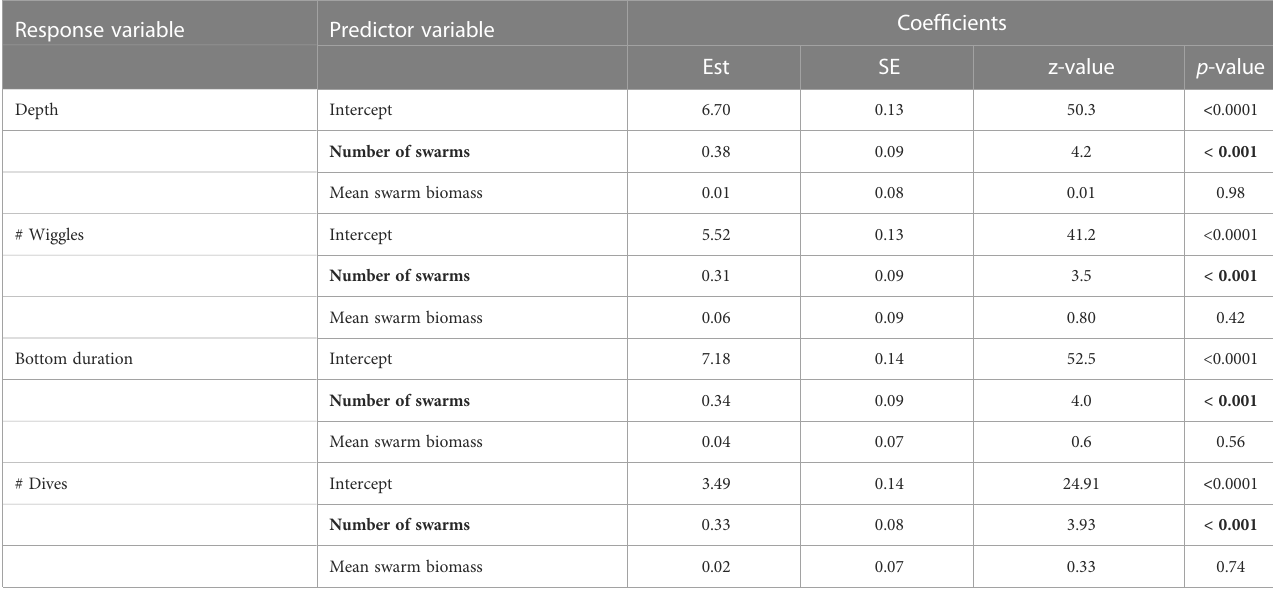
TABLE 4 Results of the four generalised linear mixed effects models for each dive metrics in relation to krill swarm metrics (number of swarms and mean swarm